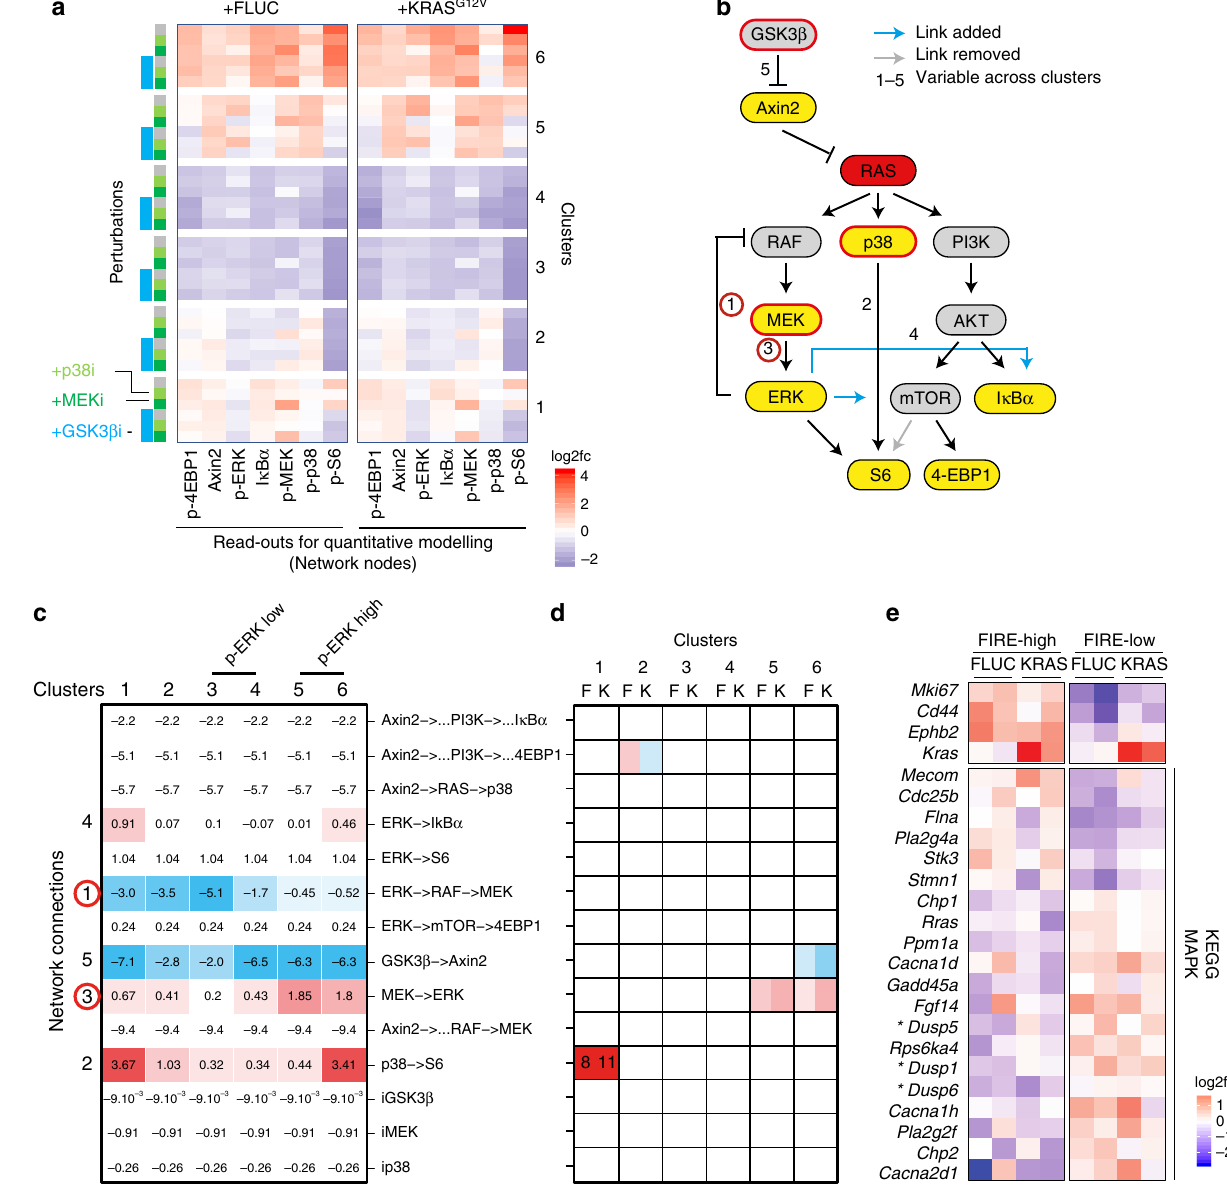
Fig. 7 Network quanti fi cation identi fi es cell type-speci fi c differences in KRAS to ERK signalling. a Protein phosphorylation and abundance CyTOF data by treatment and cell clusters, as in Fig. 6c. Log2 fold changes to average untreated FLUC-induced control line are given. b Signalling network structure used for modelling. The network was re-parametrised from a starting network, using the experimental data to remove and add connections, denoted by grey and blue arrows, respectively. c Signalling quanti fi cation of identi fi able network links using Modular Response Analysis. Numbers 1 – 5 in panels ( b ) and ( c ) show network connections with signi fi cant differences between clusters in order of detection. Red circles mark MEK-ERK and ERK-MEK connections identi fi ed as having different strengths in clusters with high vs. low ERK phosphorylation after KRAS G12V induction. d MRA modelling of differences between KRAS G12V - induced and FLUC control cells within each cluster. K and F mark KRAS G12V and FLUC control cluster pairs, respectively. Cluster pairs exhibiting KRAS G12V - speci fi c differences are shown in red and blue, indicating regulation strengths. e Colour-coded gene expression data from cells sorted by high and low FIRE activity, as indicated. Upper panel shows marker genes ( Mki67 , encoding Ki67, for proliferative cells, Cd44 and Ephb2 for crypt cells and Kras ), lower panel shows 20 signi fi cantly regulated genes between the conditions. In total, 269 genes encoding MAPK network components in KEGG were tested. Asterisks indicate dual-speci fi city